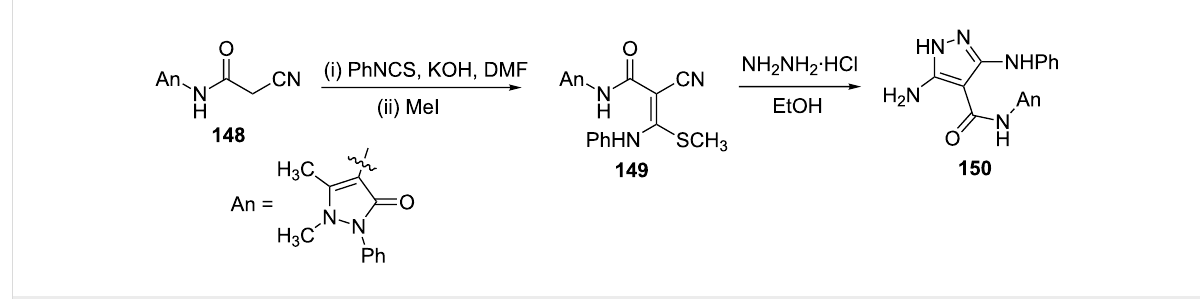
Scheme 41: Synthesis of the 5-aminopyrazole derivative 150 .